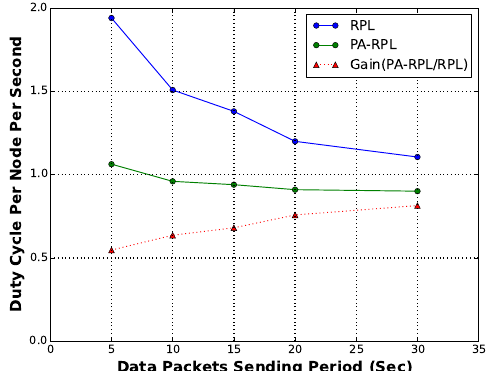
Figure 15. Gain as a function of sending period (in-network aggregation